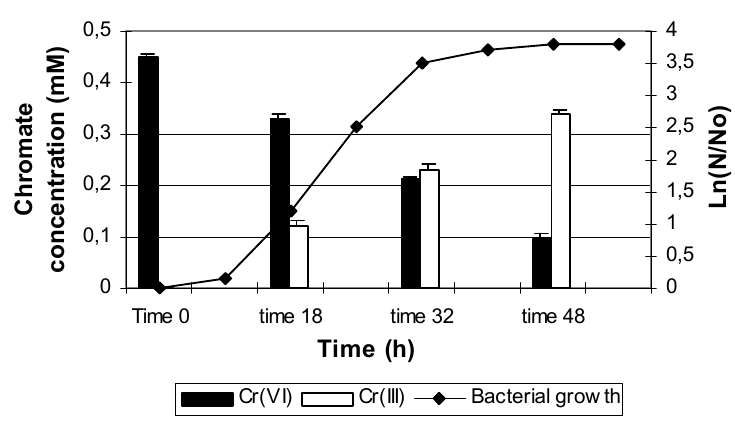
FIGURE 1. Reduction of chromate by S. marcescens cell